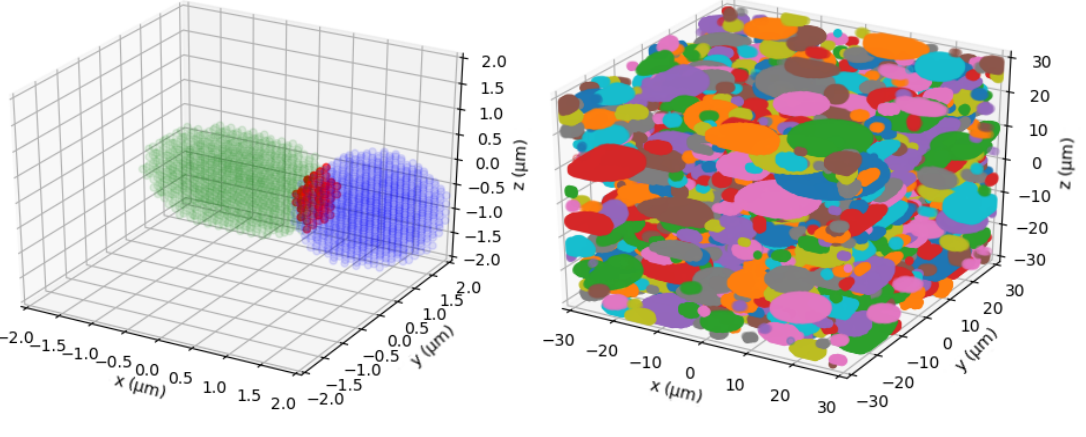
Figure 3. Stages of Random Sequential Addition